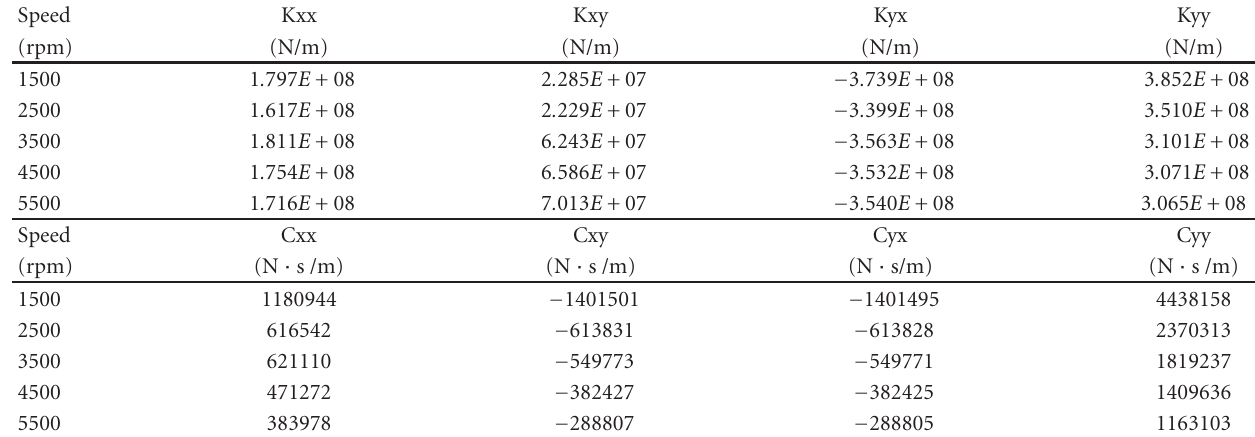
Table 2: The four sti ff ness and damping coe ffi cients for the two groove axial